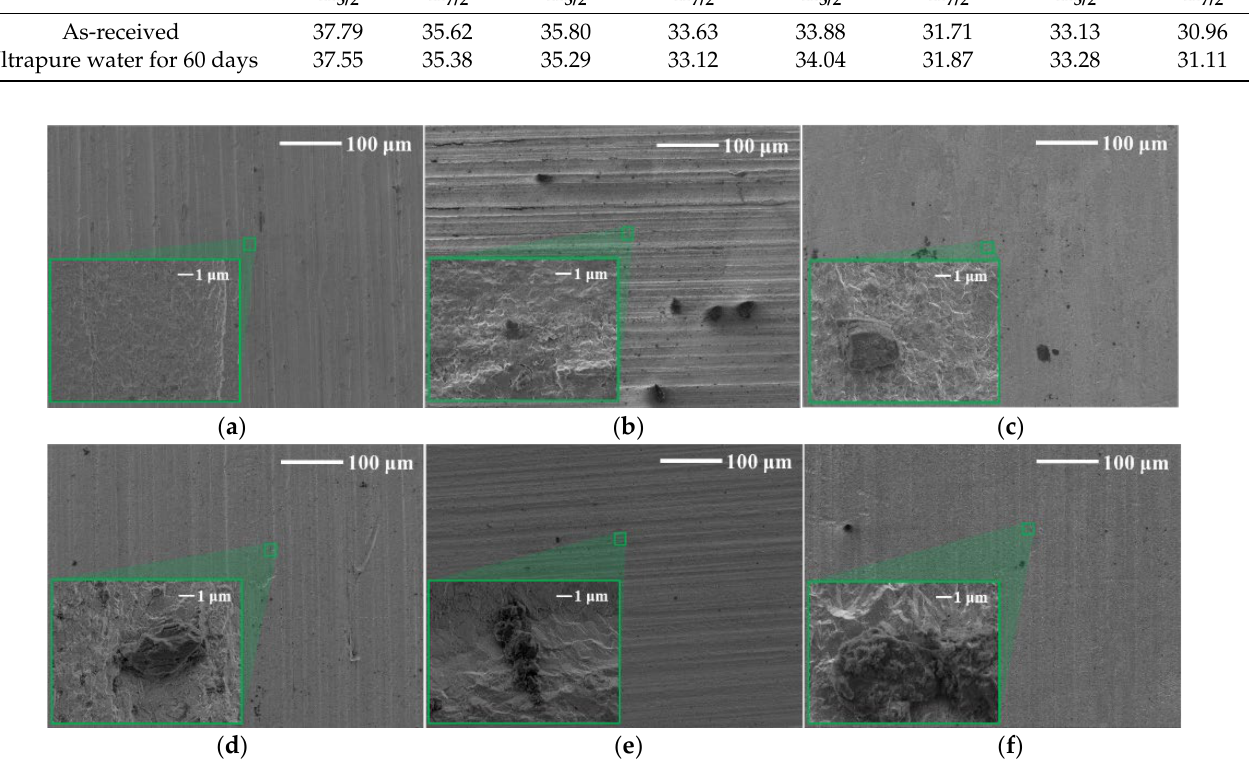
Figure 7. SEM images of ( a ) as-received tungsten and tungsten in ultrapure water for ( b ) 7 days, ( c ) 14 days, ( d ) 21 days, ( e ) 30 days and ( f ) 60 days. (The image in green square is with high magnification.).